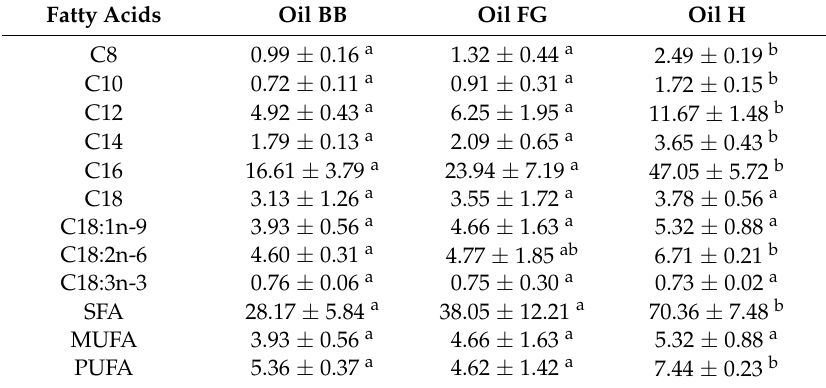
Values (µg/mL) represent means ± standard errors. Means in the same row accompanied by different letters are significantly different between treatments at Fisher’s LSD = 0.05, n = 4 per experimental replicate. SFA = sum of the saturated fatty acids (C8 to C18), MUFA = sum of the monounsaturated fatty acids (C18:1n9), PUFA = sum of the polyunsaturated fatty acids (C18:2n6 + C18:3n3). The lipid components in the table are arranged based on the fatty acid composition with the number before the colon representing total number of carbons, while the numbers after the colon represents the total number and position of first double bonds (e.g., C16:3n3 = 16 carbons with 3 double bonds; first double located at carbon 3 counting from the terminal end). Natural soap acronyms: BB = base bar (control), FG = forest grove, H = Hibiscus rose hip.